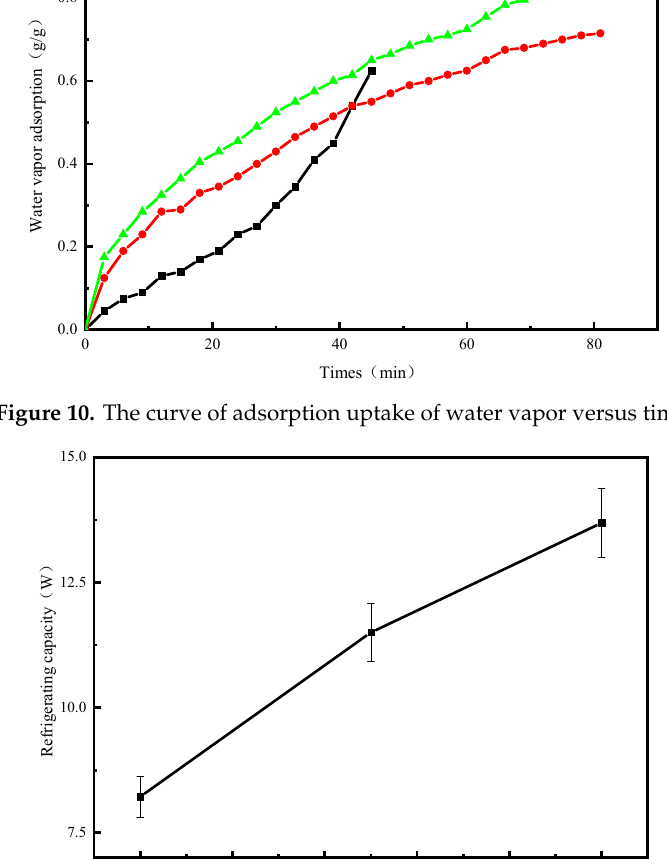
Figure 11. Cooling capacity of the system at different evaporation temperatures.